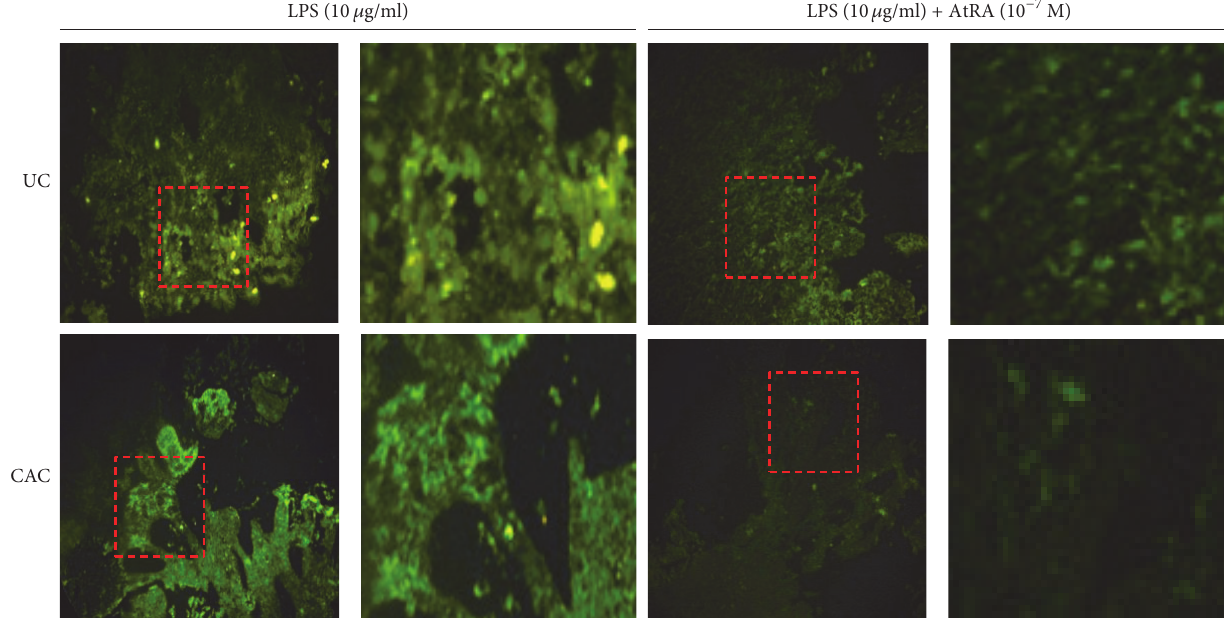
Figure 13: Effect of LPS (10 𝜇 g/ml) in the presence or absence of AtRA (10 −7 M) on NOS2 (iNOS) expression in inflamed colonic mucosa of patients with active UC and CAC. AtRA reduced NOS2 expression in colonic mucosa (UC: ulcerative colitis; CAC: colitis associated